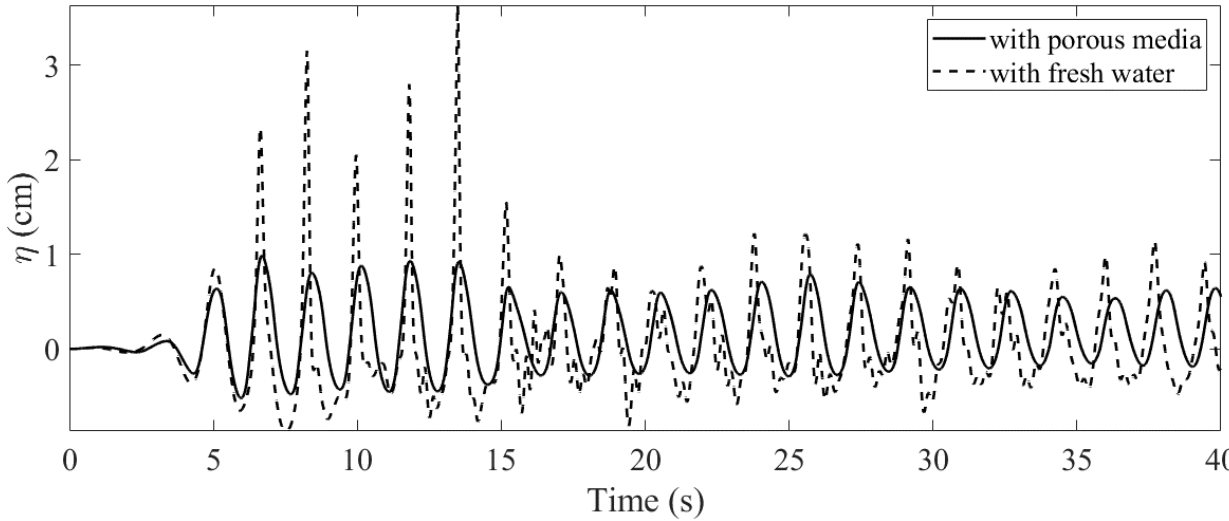
Figure 32. The wave elevations on the left-side wall of the tank with and without porous